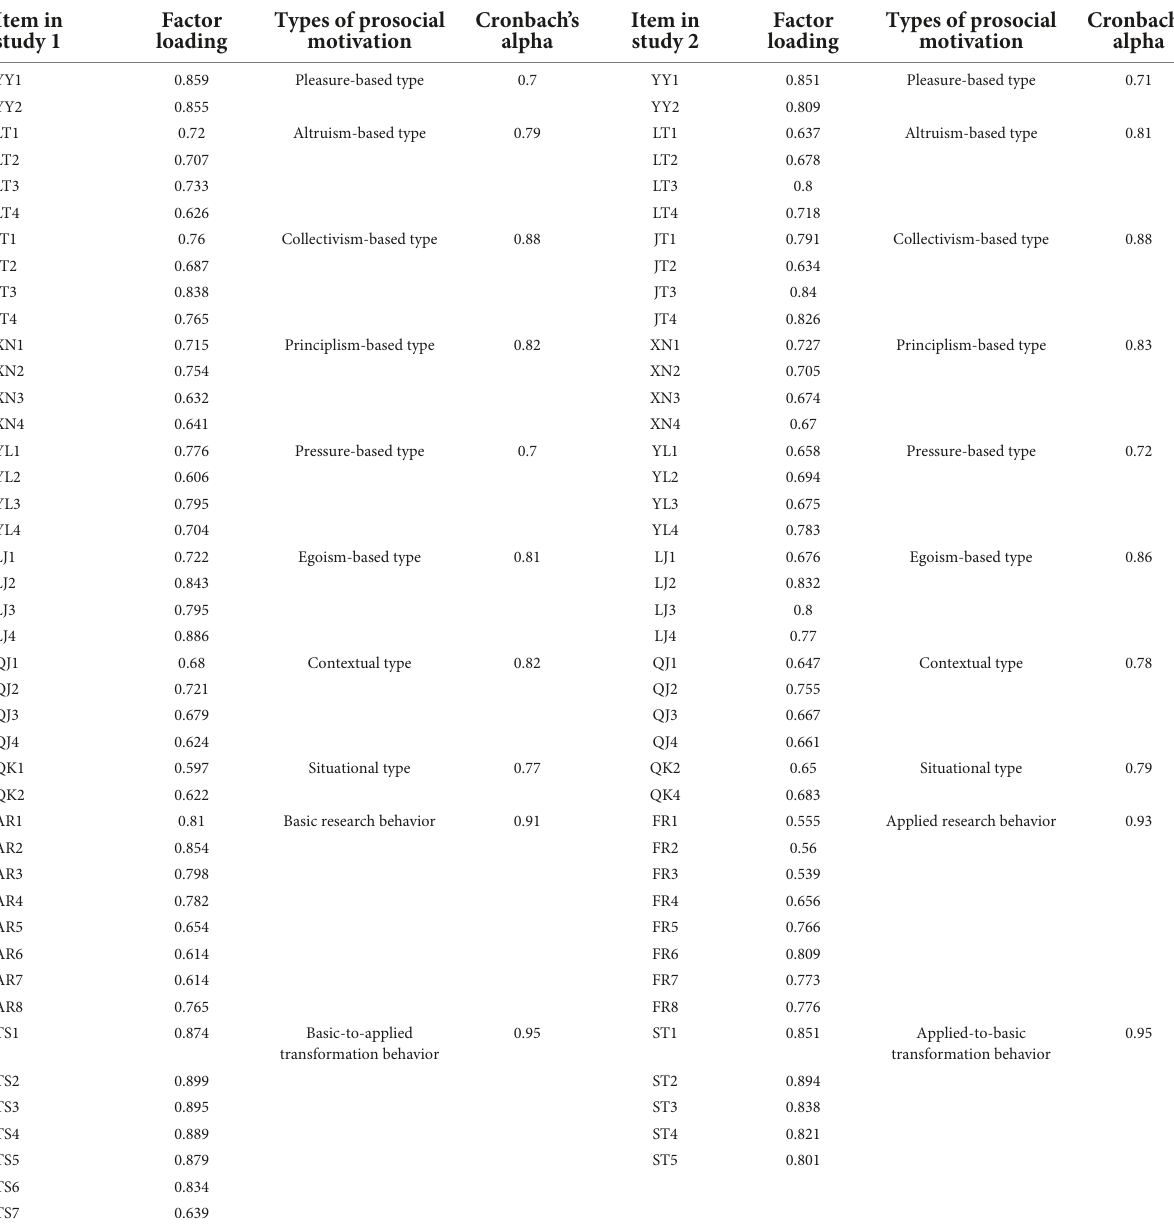
TABLE 3 Analysis of the reliability and the